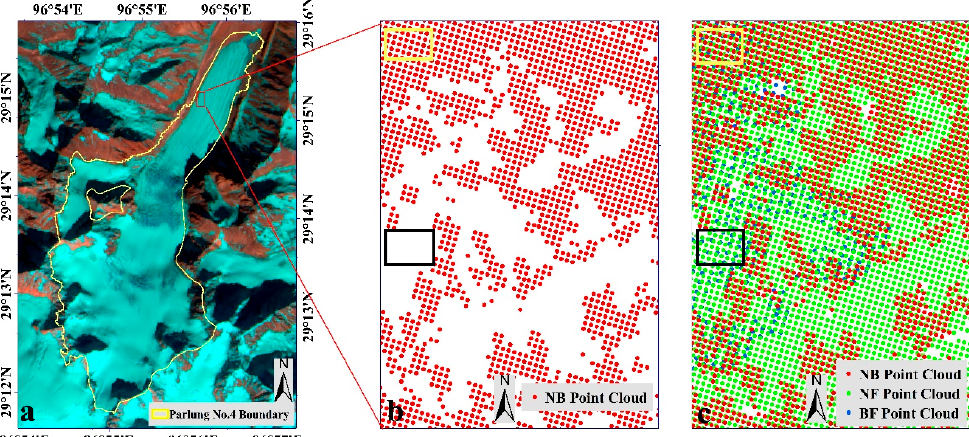
Figure 6. The point cloud of the Parlung No.4 glacier derived by ZY-3 TLA data. ( a ) The overview of the Parlung No.4 glacier (The basemap is the same as in Figure 1b); ( b ): The point cloud generated with the one pair (NB) combination; ( c ) The point cloud obtained by fusing the NB (red points), NF (green points) and BF (blue points) observations.